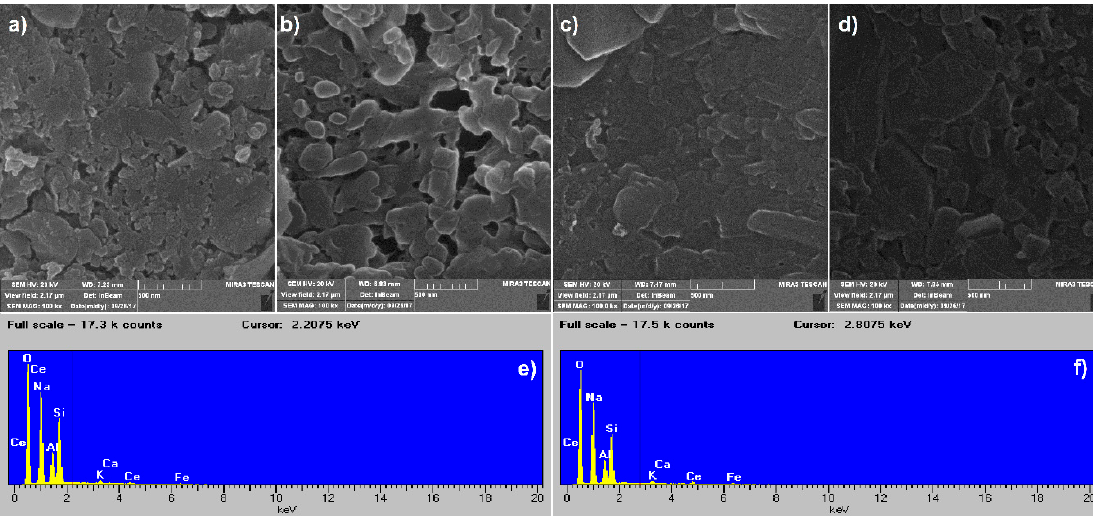
Figure 10. SEM images of: ( a ) GP, ( b ) GP_CeO 2 _com, ( c ) GP_CeO 2 _ SPRT, ( d ) GP_CeO 2 _ MGNP, ( e ) and ( f ) corresponding energy dispersive spectrometer (EDS) spectra of grains and grain boundary GP_CeO 2 _MGNP.